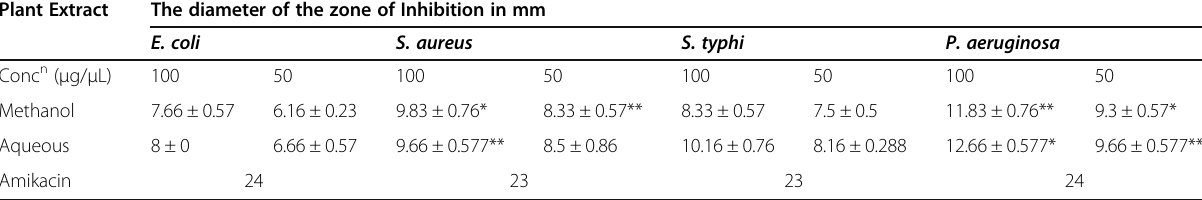
Table 4 Antibacterial growth inhibition data Plant Extract The diameter of the zone of Inhibition in